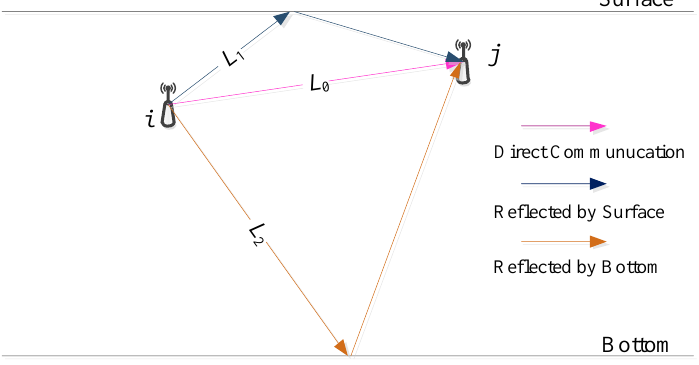
Figure 1. Multipath propagation in shallow